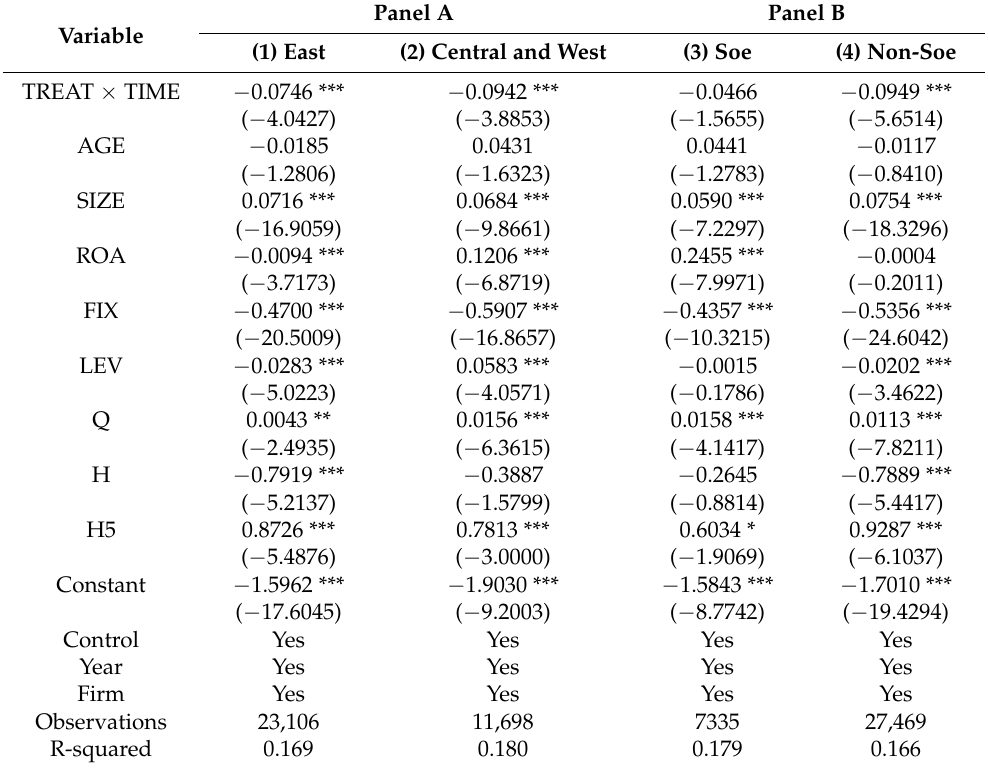
Table 8. Cross-sectional